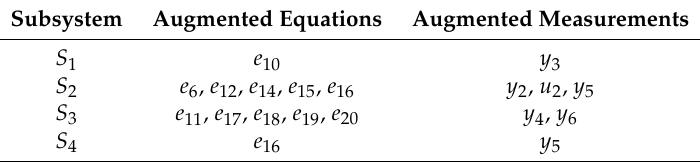
Table 2. Set of augmented constraints and measurements for each subsystem model.